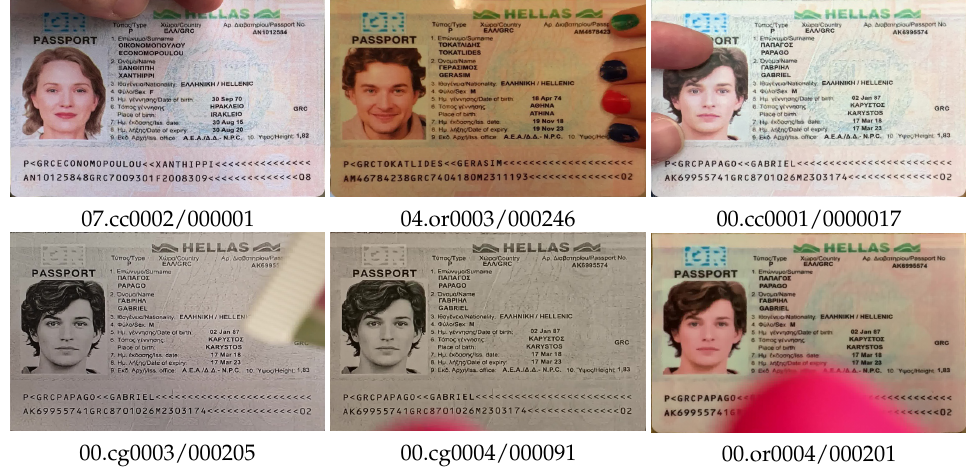
Figure 4. Overlapping variation of document images, type